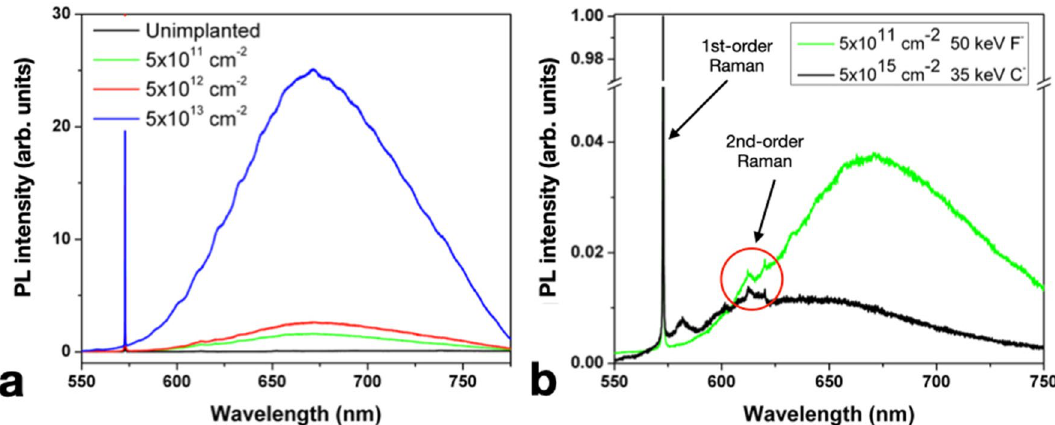
Figure 1. ( a ) PL spectra acquired under 532 nm laser excitation wavelength from regions implanted with different 50 keV F- ion fluences in the 5 × 10 11 –1 × 10 13 cm −2 range. The PL spectrum of a pristine region of the sample is included for the sake of comparison (black line). ( b ) Comparison of the PL spectrum acquired from the region implanted with 5 × 10 11 cm −2 50 keV F-ion fluence (green line) with a sample region irradiated with 35 keV C – ions at 5 × 10 15 cm −2 fluence (black line). Both curves are normalized to the first-order Raman peak. The first-order and second-order Raman features of diamond are